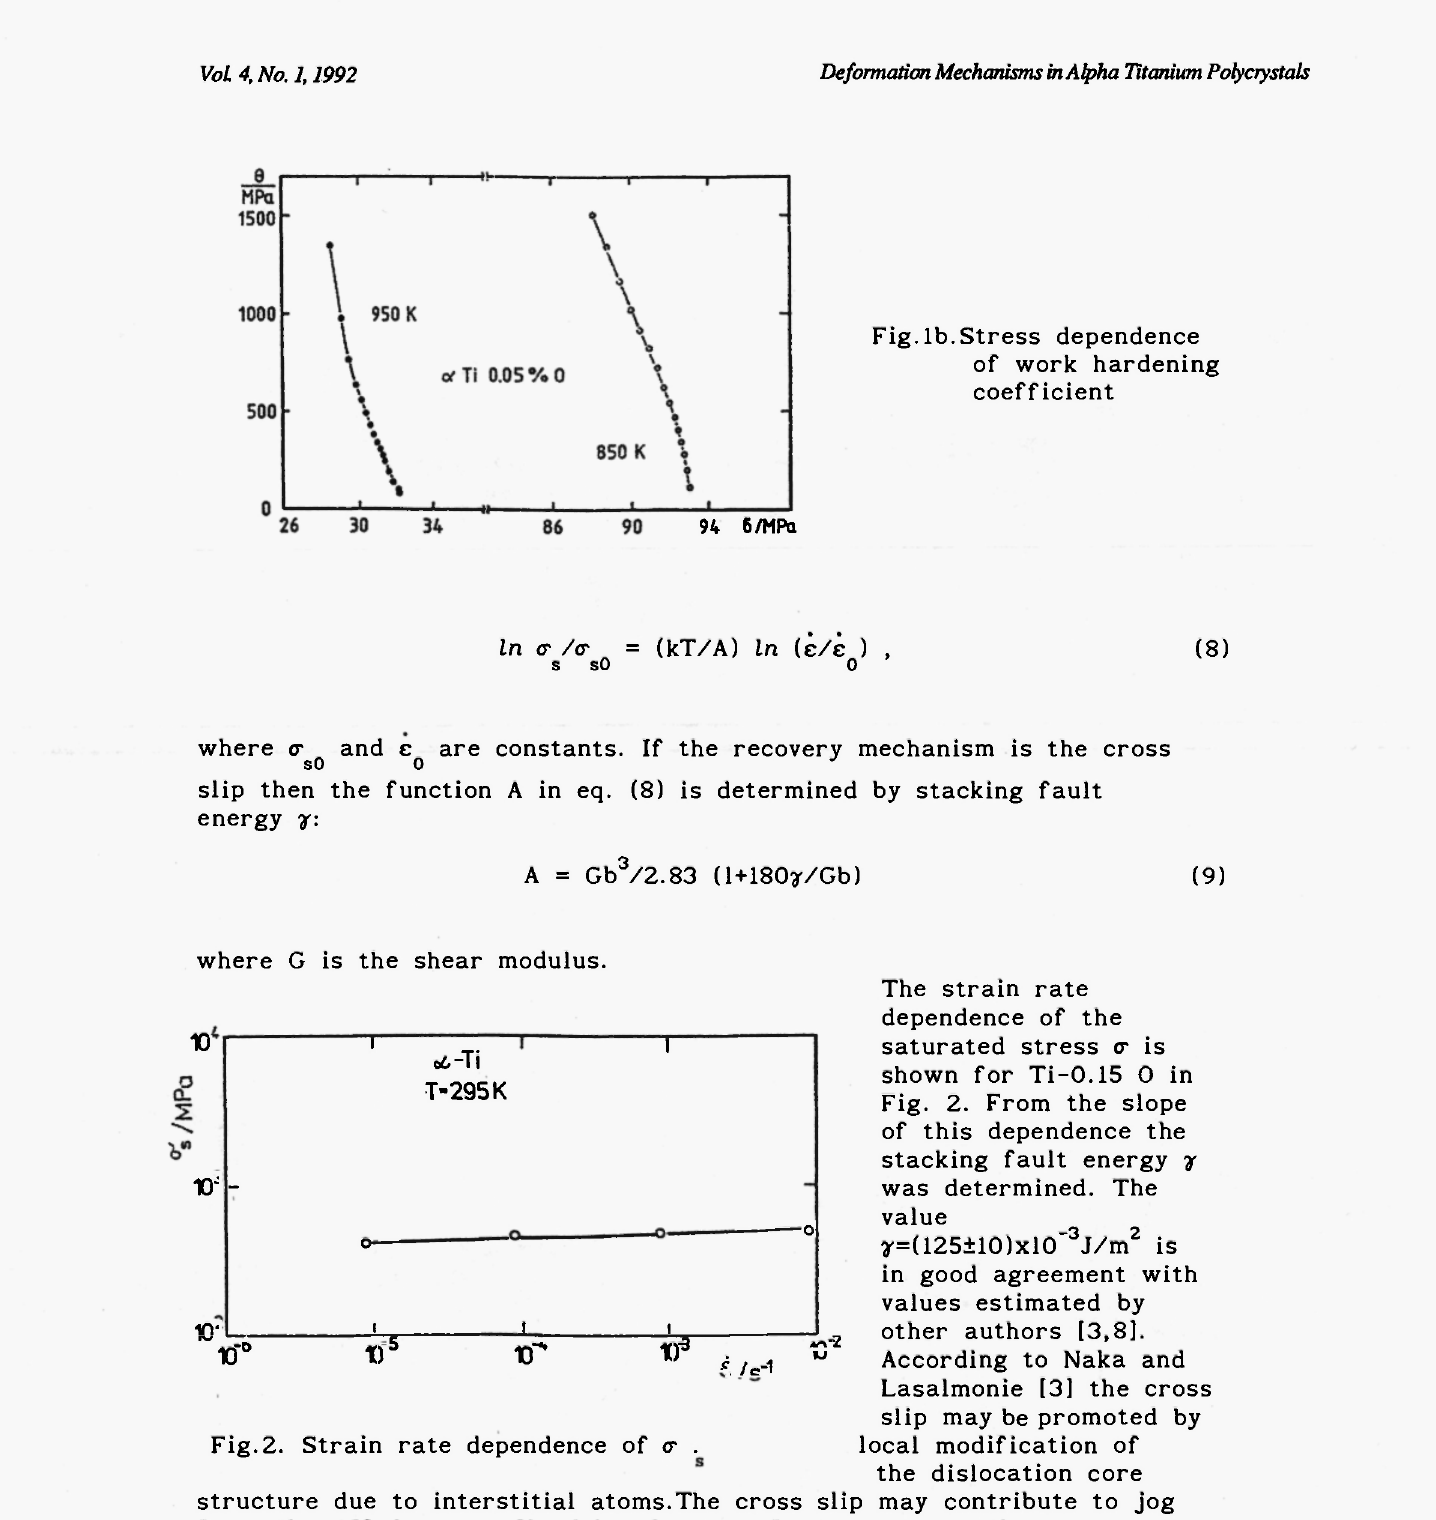
the dislocation